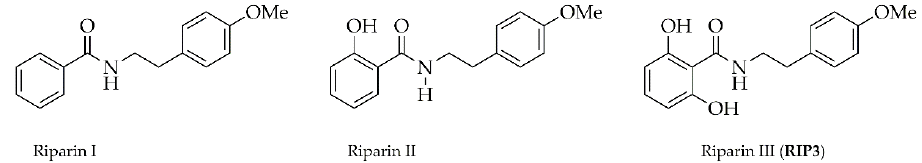
Figure 1. Chemical structures of riparins I, II, and III (RIP3).